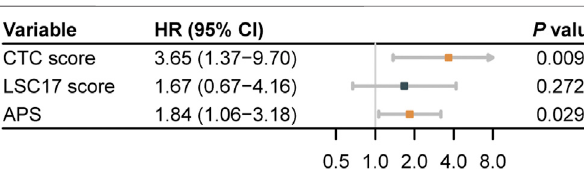
FIGURE 5 | Forest plot for multivariable Cox regression, incorporating three acute myeloid leukemia prognostic scores of the validation set TCGA-